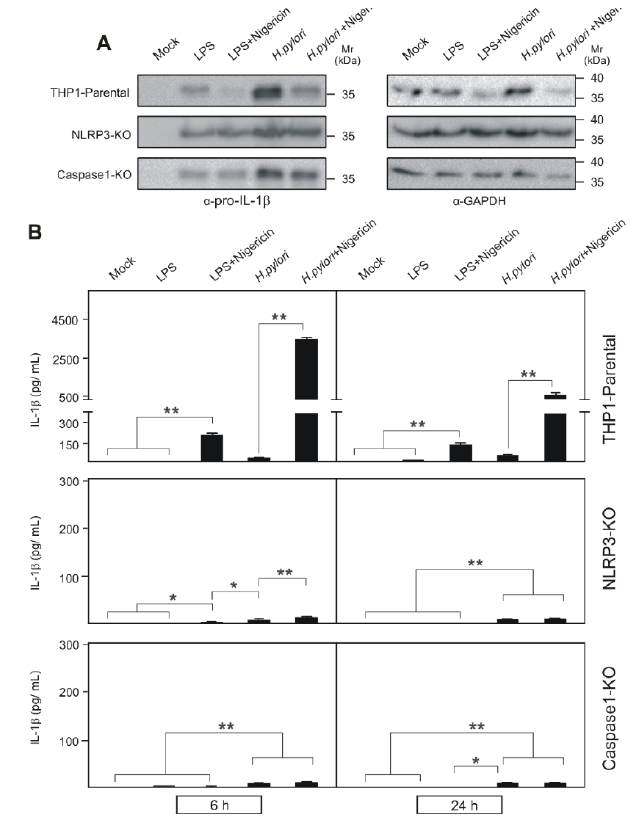
Figure 3. Expression of pro-IL-1 β in THP1 parental, THP1 NLRP3-KO and THP1 Caspase-1-KO monocytes after E. coli LPS treatment, H. pylori infection and NLRP3 inflammasome activation with Nigericin were shown in Western blots in comparison with control GAPDH as loading reference ( A ). GAPDH, a known target for active caspase-1 [69] is also cleaved in THP1 parental cells but not in NLRP3-KO or caspase-1-KO cells after Nigericin treatment, which suggests pyroptotic death ( A ). NLRP3 inflammasome activation is evident with cleavage of pro-IL-1 β and secretion of high amount of mature IL-1 β from THP1 parental monocytes but not in NLRP3-KO or caspase-1-KO cells after Nigericin treatment, however, both knockout cells secreted basic background secretion after H. pylori infection, which again confirms the inflammasome or caspase-1-independent secretion of IL-1 β by H. pyloi ( B ). * p ≤ 0.05; ** p ≤ 0.01